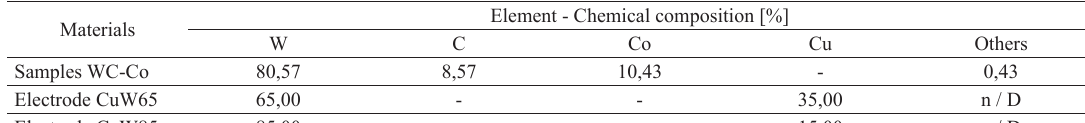
Table 2. Chemical composition of cemented carbide and electrodes.